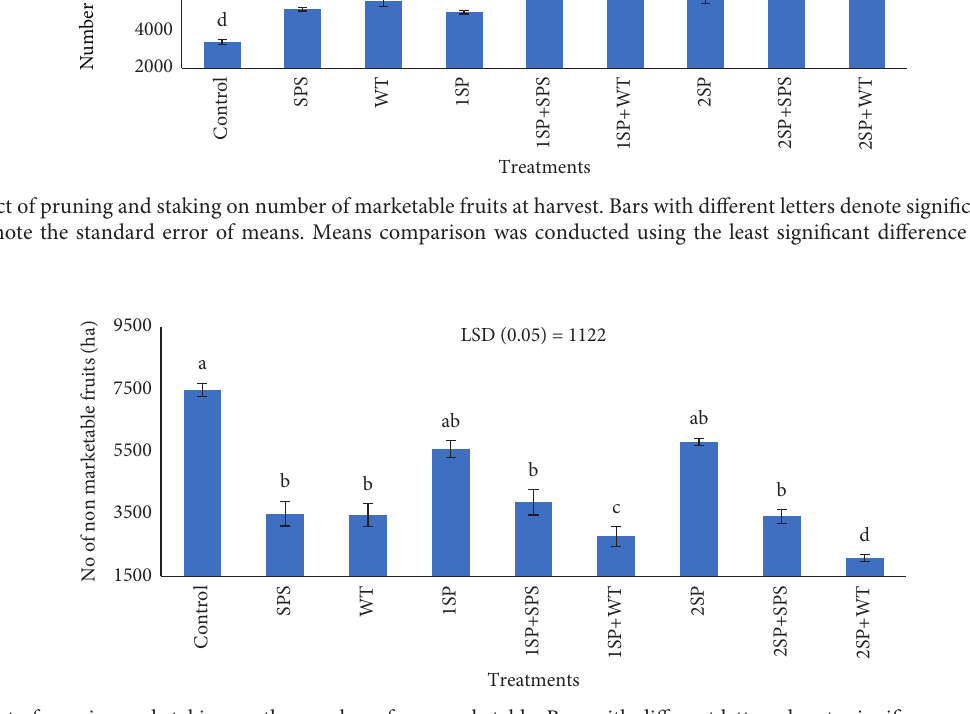
Figure 4: Effect of pruning and staking on the number of nonmarketable. Bars with different letters denote significance at p < 0 . 05. Error bars denote the standard error of means. Means comparison was conducted using least significant difference ( p < 0 . 05).